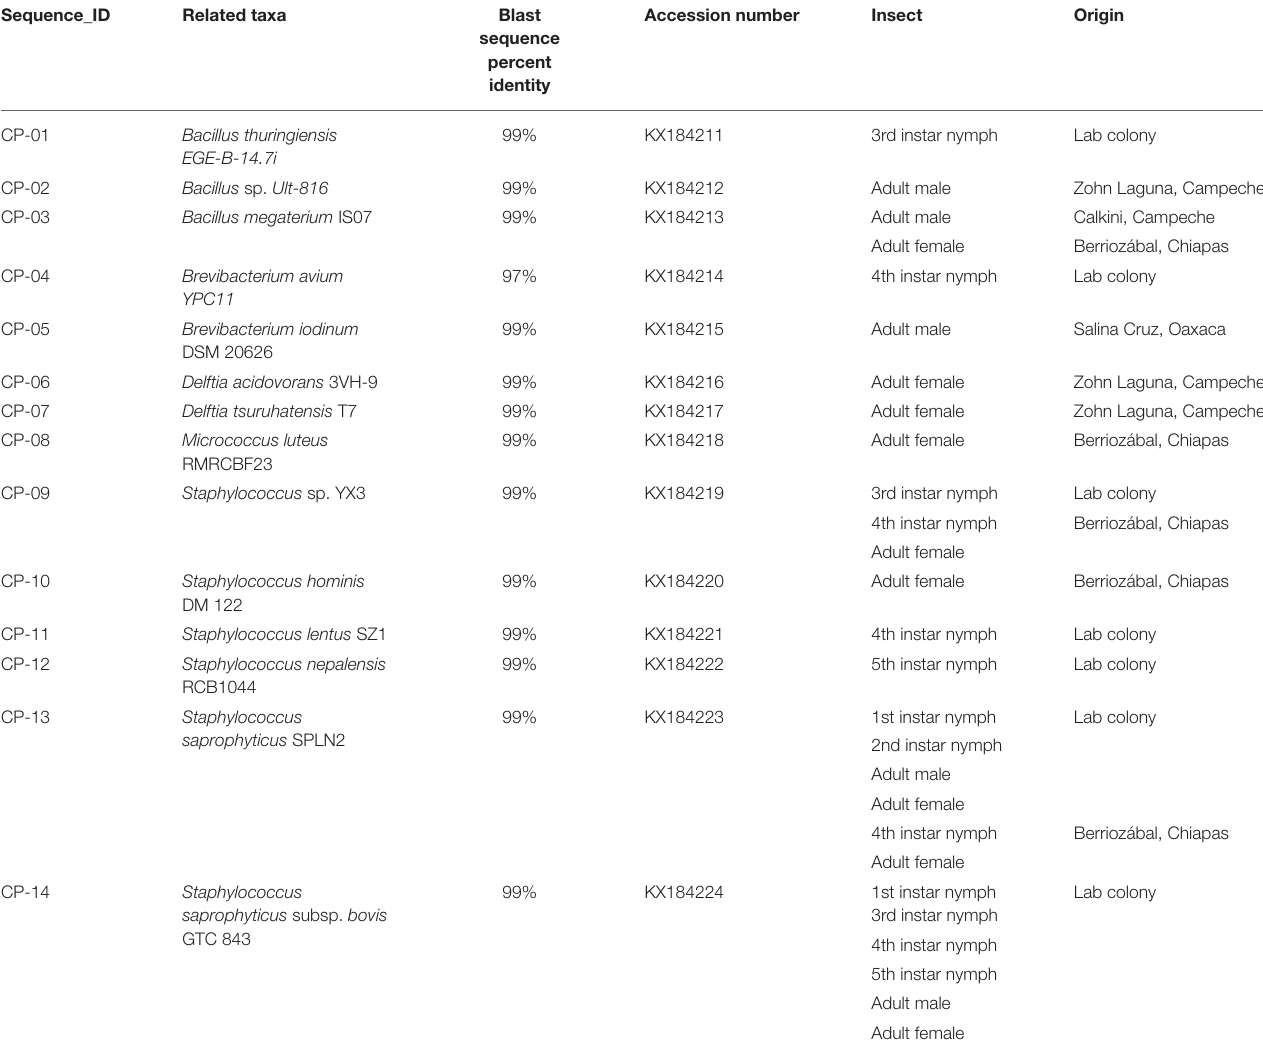
TABLE 1 | Bacterial species associated to 16S rRNA sequences obtained from field-collected and laboratory Triatoma dimidiata specimens.